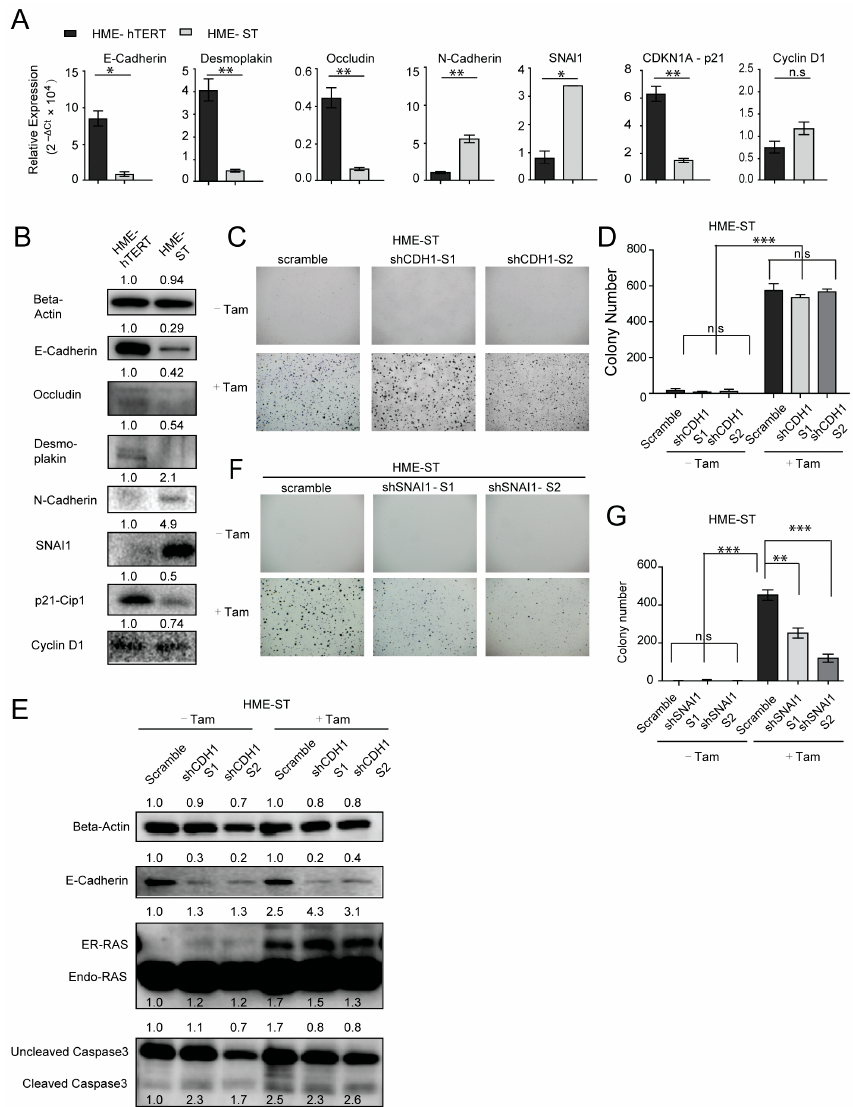
Figure 5. SV40 small T antigen functions to induce EMT in HME-hTERT cells and enables the cells to survive and grow in soft agar independent of CDH1. ( A ) RT-PCR analysis of the indicated genes was performed on RNA samples extracted from HME-hTERT and HME-ST cells grown in anchorage-independent soft-agar colony formation assays (CFAs). Statistical significance is reported as p values computed using mean − ∆ Ct values and normalized SD; ** p ≤ 0.01; * p ≤ 0.05, n.s: Not Significant. Data shown are the relative expressions ((2 − ∆ Ct × 10 4 ) ± normalized SD) from duplicate determinations of a single experiment that is representative of three such experiments. ( B ) Corresponding immunoblot analysis on samples similarly prepared as in panel A to evaluate the levels of the indicated proteins; samples were extracted from cells grown in soft agar. ( C ) Representative microscopic images of soft-agar CFAs of HME-ST cells expressing either a control shRNA (scramble) or two different shRNAs targeting CDH1, with or without tamoxifen-induced expression of CA-NRAS. ( D ) Quantitation of the data from the experiment shown in panels C; data are presented as mean ± SD numbers of colonies counted in three separate fields. ( E ) Immunoblot analysis of protein samples extracted from cells in soft agar corresponding to the conditions of panels C and D. ( F ) Representative microscopic images of soft agar colonies of HME-ST cells with or without expressing CA-NRAS and with the expression of either a control shRNA or two different shRNAs targeting SNAI1. ( G ) Quantitation of the data presented in panel F; data are presented as mean ± SD. ** p ≤ 0.01, *** p ≤ 0.001 (Student’s t